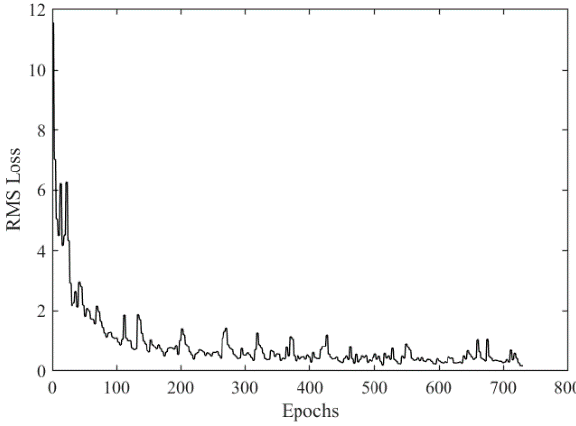
Figure 10. Epochs vs. root-mean-square (RMS) loss.